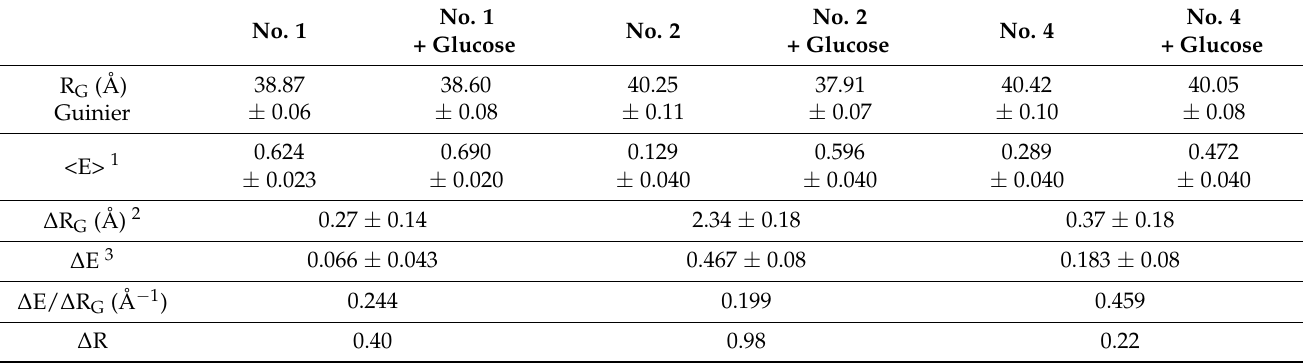
Table 1. Comparison of structural parameters for the different sensor